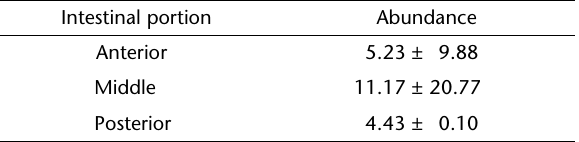
Table III. Proportion of pregnant and non-pregnant specimens of S. nanii of P. argenteus , from the São Francisco River, Três Marias, Minas Gerais, Brazil, in the rainfall